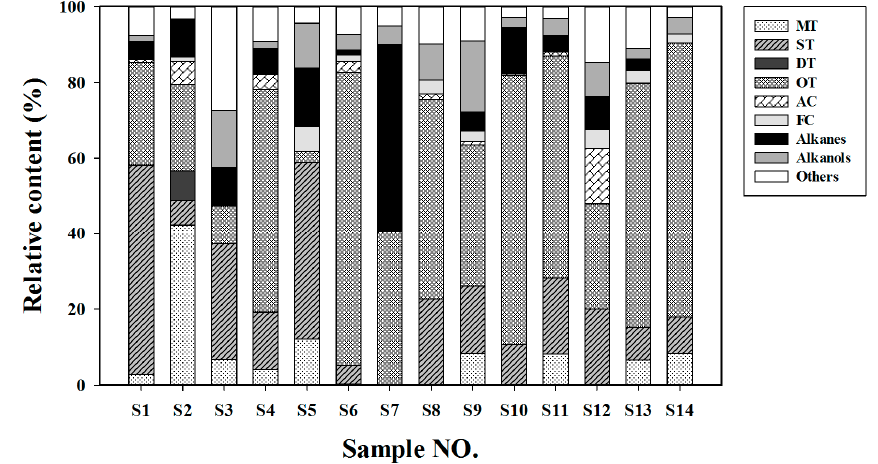
Figure 3. Relative content of volatile constituents in the leaves of 14 samples. Sample numbers are the same as in Table 2. MT, monoterpenes; ST, sesquiterpenes; DT, diterpenes; OT, oxygenated terpenes; AC, aromatic compounds; FC, fluorinated compounds; TC, total compounds.